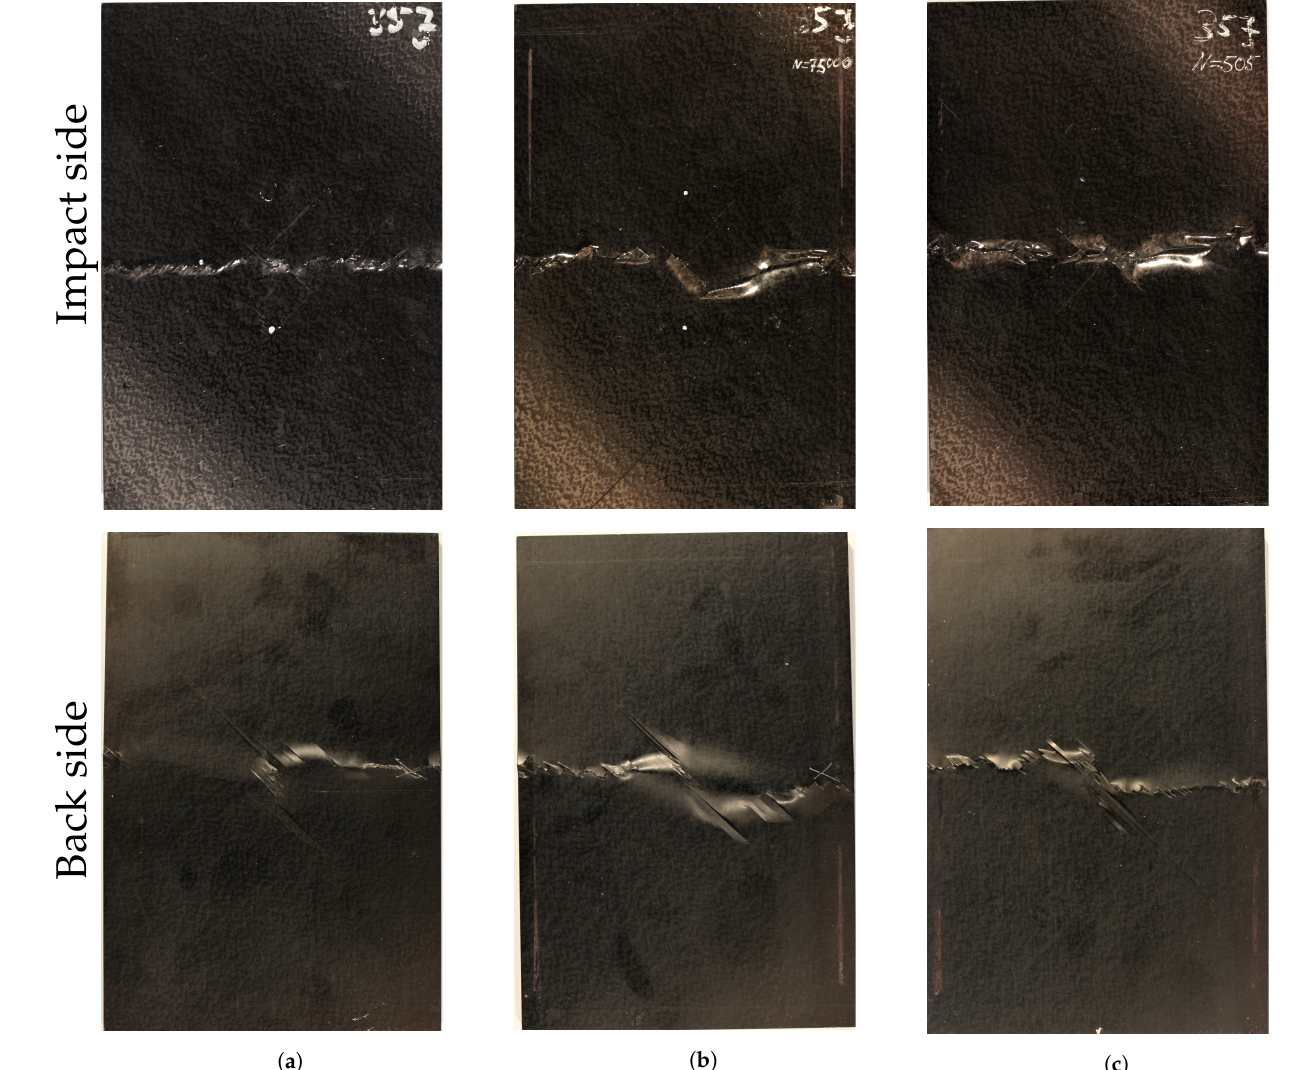
Figure A4. Exemplary images of three specimens after ultimate failure. The upper row shows the impact side, the lower row the back side. ( a ) Failure type I (Quasistatic failure, example: CAI failure), ( b ) Failure type II (Cyclic failure, example: 70% load level), ( c ) Mixed failure type (Cyclic failure, example: 90% load